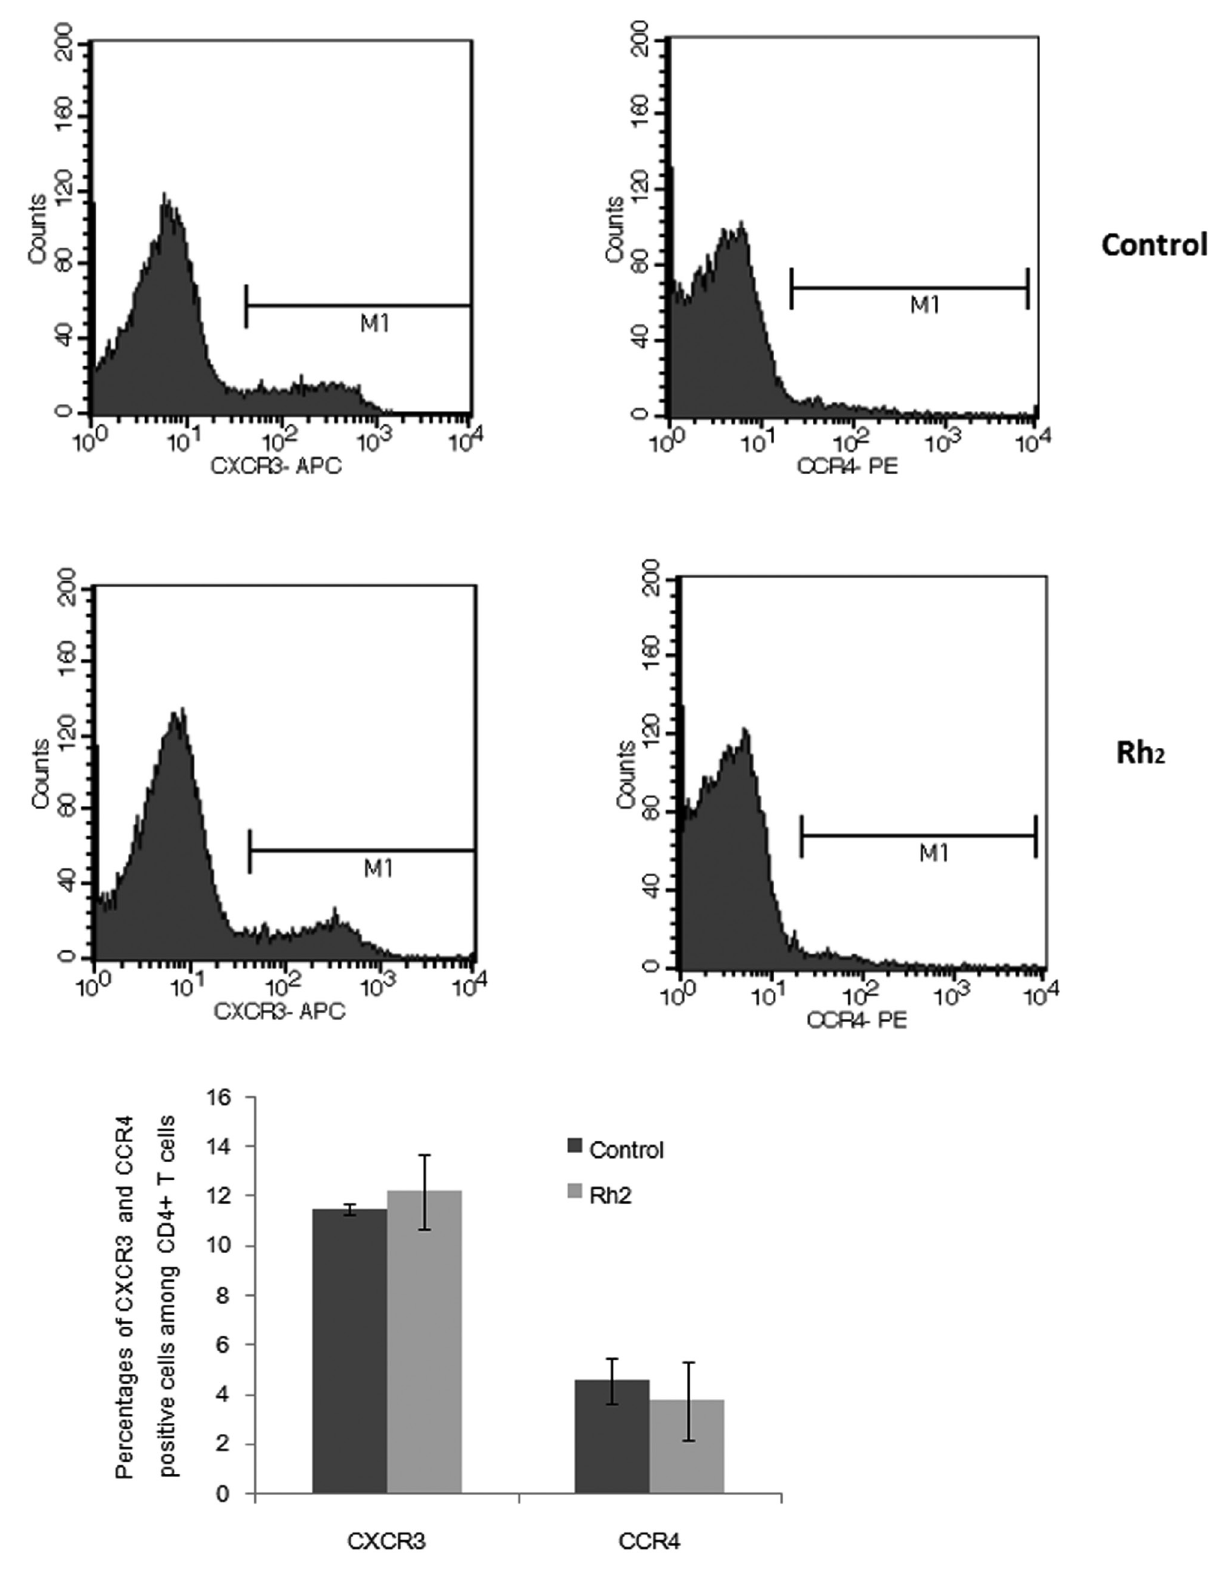
on CXCR3 and CCR4 among CD4 + T cells. (Mean ± SD, N=3), * P<0.05 vs. control; ** P<0.01 vs. Figure 3: Effects of ginsenoside Rh 2